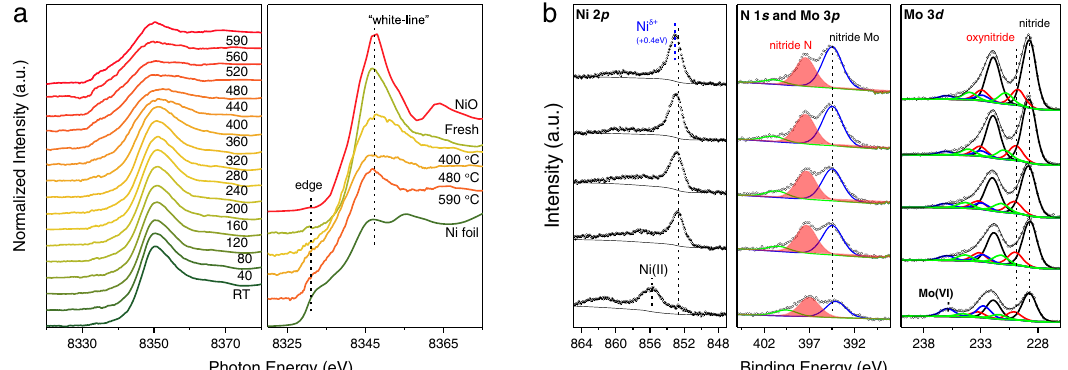
Fig. 3 In-situ QXANES characterization and AP-XPS spectroscopy of 4%Ni-4nm/ γ -Mo 2 N catalyst treated at different temperature. a The QXANES spectra of 4%Ni-4nm/ γ -Mo 2 N catalyst from room temperature to 590 °C, the right panel of a is a comparison of Ni K edge of 4%Ni-4nm/ γ -Mo 2 N catalyst at state of fresh, reduced at 400°C, 480 °C, and 590 °C to Ni foil and NiO. b AP-XPS pro fi les of Ni 2 p , N 1 s + Mo 3 p and Mo 3 d of 4%Ni-4nm/ γ - Mo 2 N catalyst. The fresh sample was activated in the AP-XPS chamber by a 40 mTorr N 2 /H 2 (1:3 v/v) mixture at 300, 350, 400, 500, and 520 °C for 1 h. The spectra at the Ni 2 p , Mo 3 d /3 p , N 1 s , and C 1 s XPS regions were collected at each temperature after an hour treatment. The C 1 s photoemission line with the surface carbon feature (284.8 eV) was used for the binding energy “ white-line ” of Ni-4nm/ γ -Mo 2 N-590 catalyst (Fig. 3a, right panel), which was probably due to the electron synergistic effect. The higher intensity of the Ni K edge “ white-line ” signal indicated